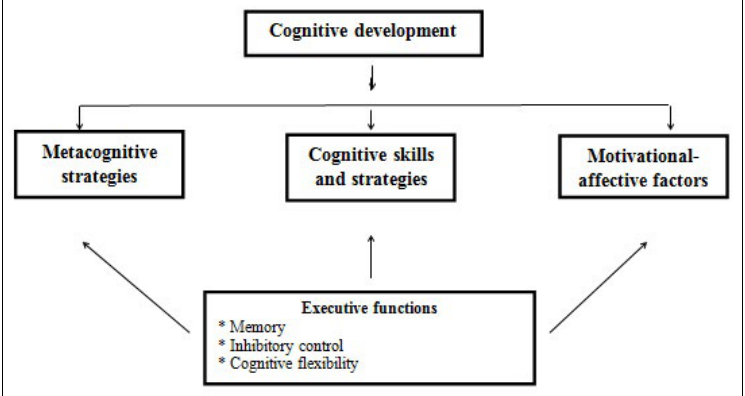
Figure 1: Conceptualisation of cognitive